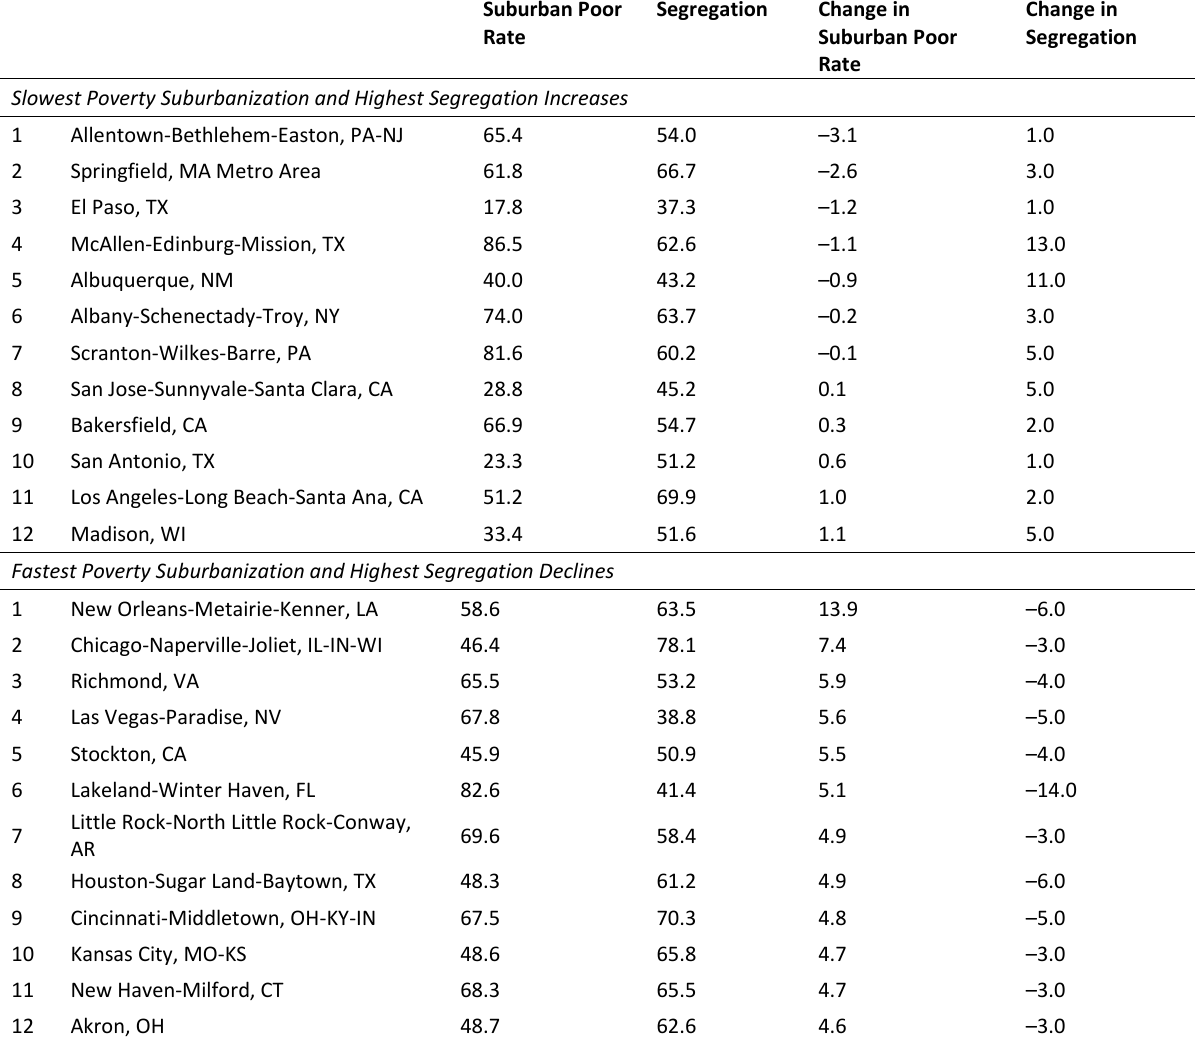
Table 5. Metropolitan areas with the slowest and fastest poverty suburbanization and highest increases and declines in residential segregation,